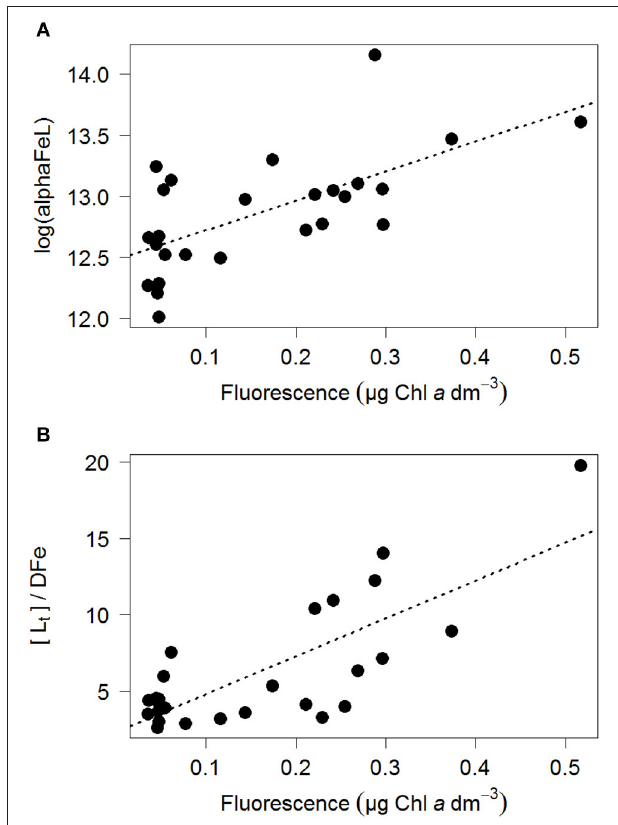
FIGURE 5 | The ratio log(alphaFeL) (A) and [L t ]/DFe (B) vs. fluorescence (as µ g Chl α dm − 3 ). For those samples where two ligands could be discriminated the data of the two ligand model was used. In Table 2 three scenarios were calculated, including the relationships, p and R 2